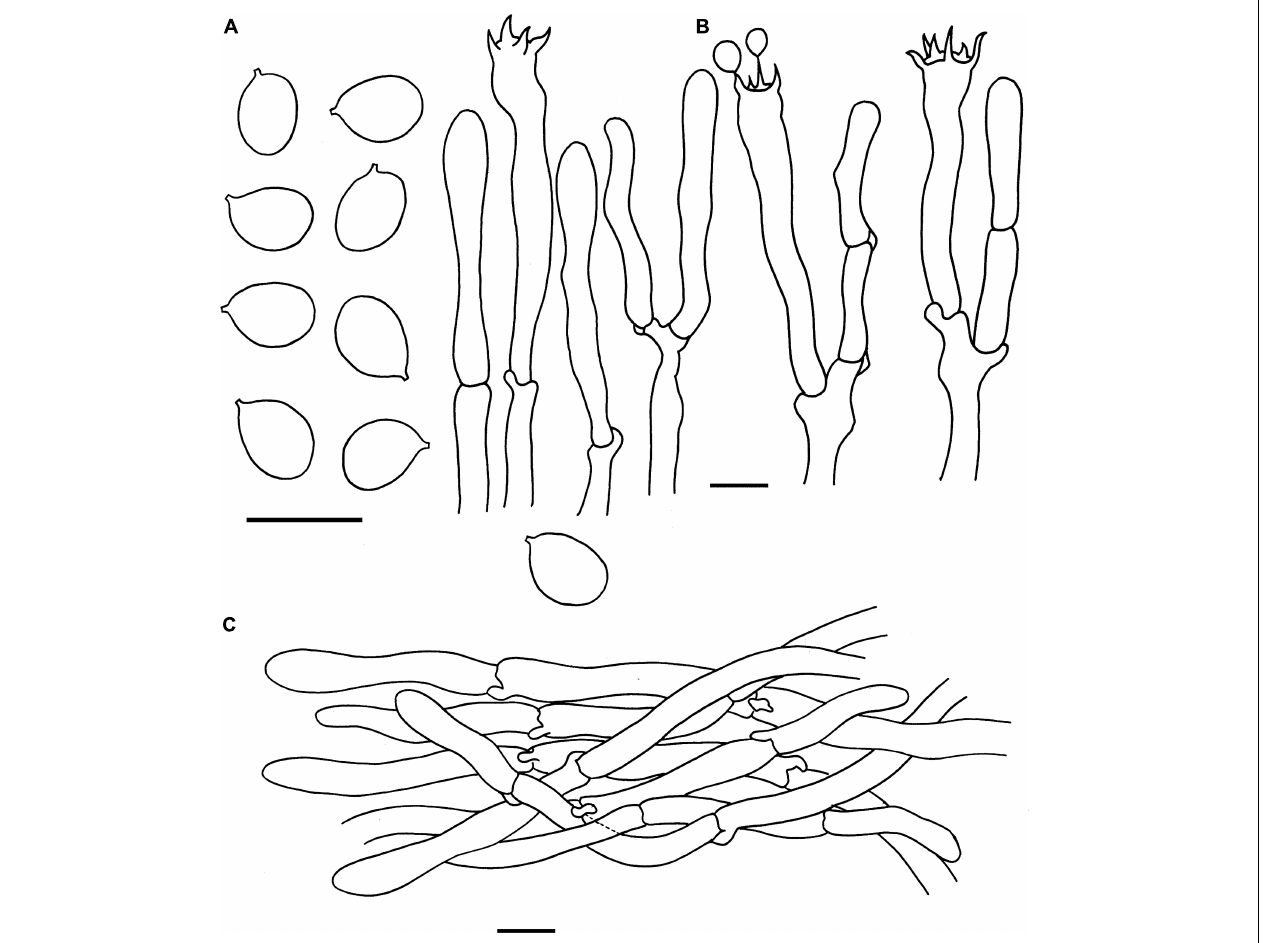
FIGURE 4 | Microscopic features of Cantharellus albopileatus (FHMU1987, holotype). (A) Basidiospores. (B) Basidia. (C) Pileipellis. Scale bars = 10 µ m. Drawings by Y. Z. Zhang.